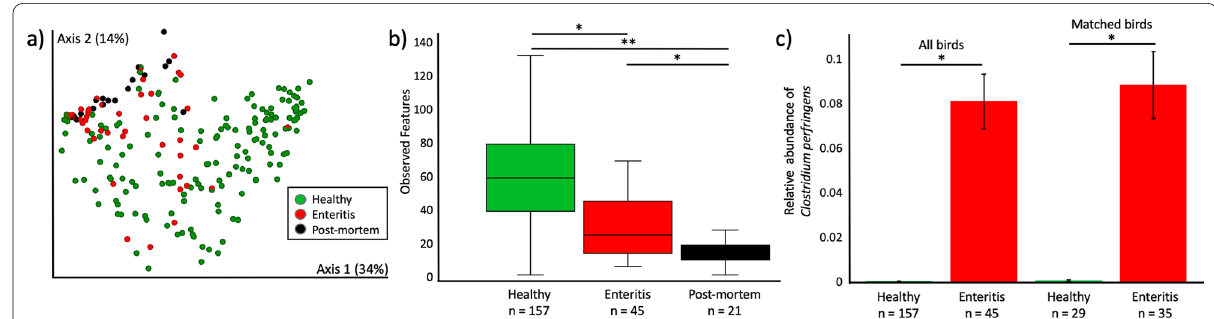
Fig. 2 Microbial community analysis in CZA lorikeets with enteritis. Microbial composition and diversity in healthy lorikeets, lorikeets with enteritis, and lorikeets that died or were euthanized due to enteritis (postmortem). a Microbial composition (Weighted UniFrac) was significantly altered (PERMANOVA p 0.001) and b microbial diversity (Observed Features) was significantly decreased (Kruskal–Wallis * p < 0.0005, ** p < 1 10 –9 ) in = × lorikeets with enteritis or postmortem lorikeets. (Also see Additional file 7). c The relative abundance of Clostridium perfringens was significantly increased in lorikeets with enteritis across all birds (ANCOM, W 1098) and across matched birds (ANCOM, W 788). “All birds” included samples = = from healthy birds that never got enteritis. “Matched birds” included only 25 birds that had both enteritis and healthy samples. n number of = samples as most birds were sampled multiple times across healthy timepoints (3 flock surveys) and some birds had more than one case of